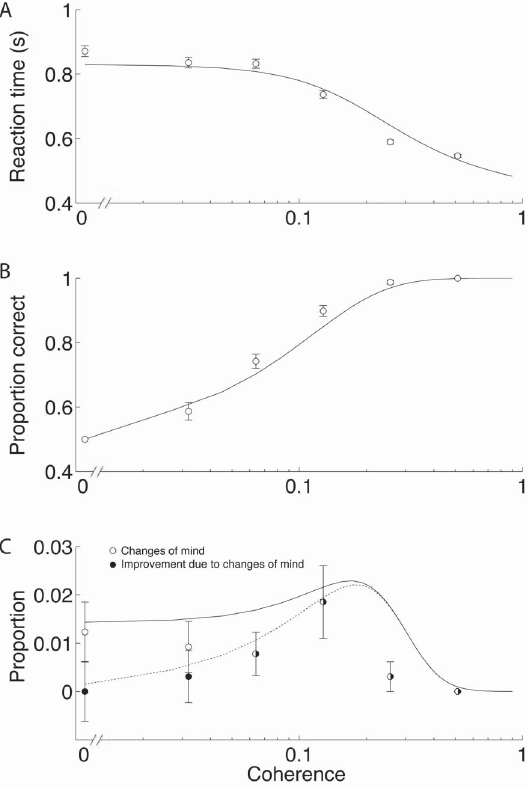
Figure 4. Psychometrics of choice for all subjects for the 30 6 condition. A: Reaction time as a function of motion coherence (specified as the proportion of dots moving in the same direction). Open circles are mean reaction times and solid lines are fits of the data to the drift-diffusion model. B: Proportion of correct trials as a function of motion coherence. The solid lines are the fits of the data. C: Proportion of trials with changes of mind as a function of motion coherence. Solid circles are for all changes of mind and open circles are the proportion of trials on which a change of mind improved performance (that is the difference in the number of changes of mind that correct an error and the number that induce an error). The solid and dotted lines are the fits of the extension of the drift-diffusion model for changes of mind to the data. Error bars show 6 one standard error and are derived from the binomial distribution for the